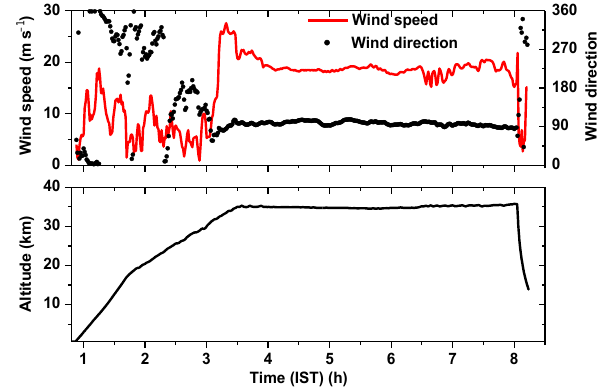
Figure 7. The location of the BEENS payload, when plotted altitude versus time, during the experiment (bottom panel) and the corre- sponding ambient wind speed and wind direction recorded then (top panel).